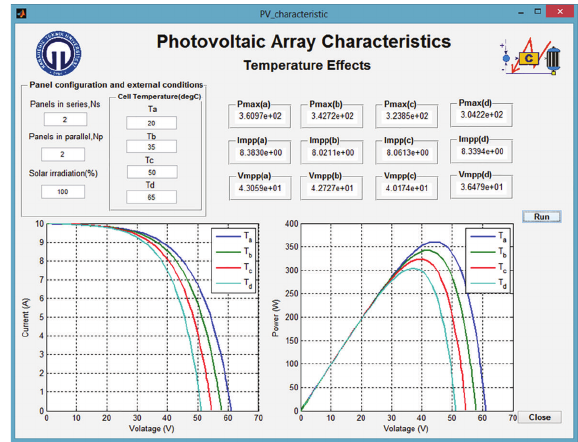
Figure 4: The photovoltaic array temperature interface.